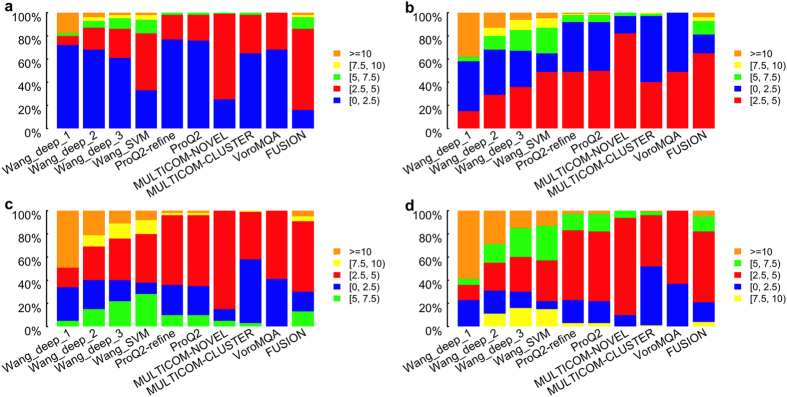
Local evaluation—the percentage of residues whose predicted deviations are within five different sets when the observed deviations of target residues belong to a range of (a) [0 Å, 2.5 Å), (b) [2.5 Å, 5 Å), (c) [5 Å, 7.5 Å), and (d) [7.5 Å, 10 Å), respectively.